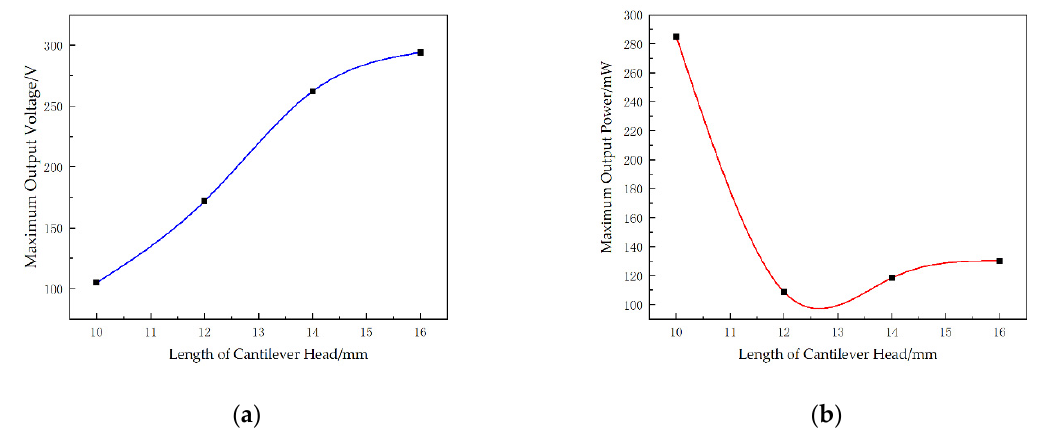
Figure 12. Maximum output performance of STTM-PEHs with different T-shaped trapezoidal cantilever head lengths. ( a ) Maximum output voltage. ( b ) Maximum output power.